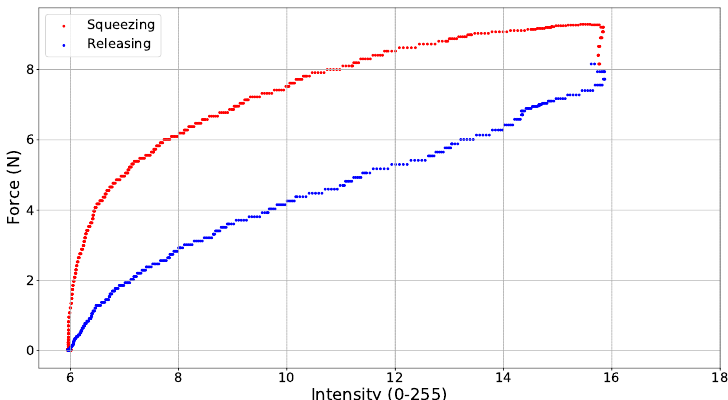
Figure A2. The calibration graph without a quasi-static regime.